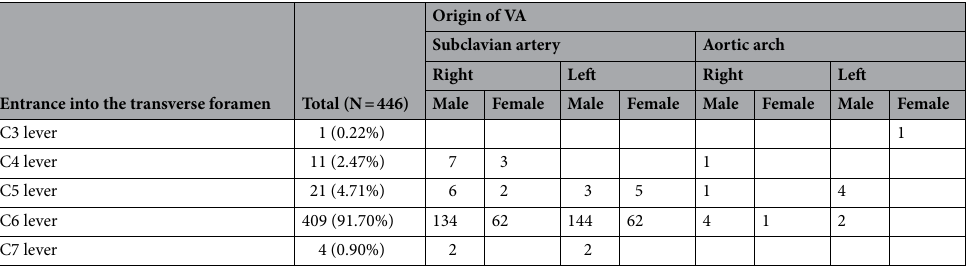
Table 1. Origin and entrance into the transverse foramen of the VA in overall population (223 subjects; 446 courses). Percentage values are shown in parenthese of overall population.